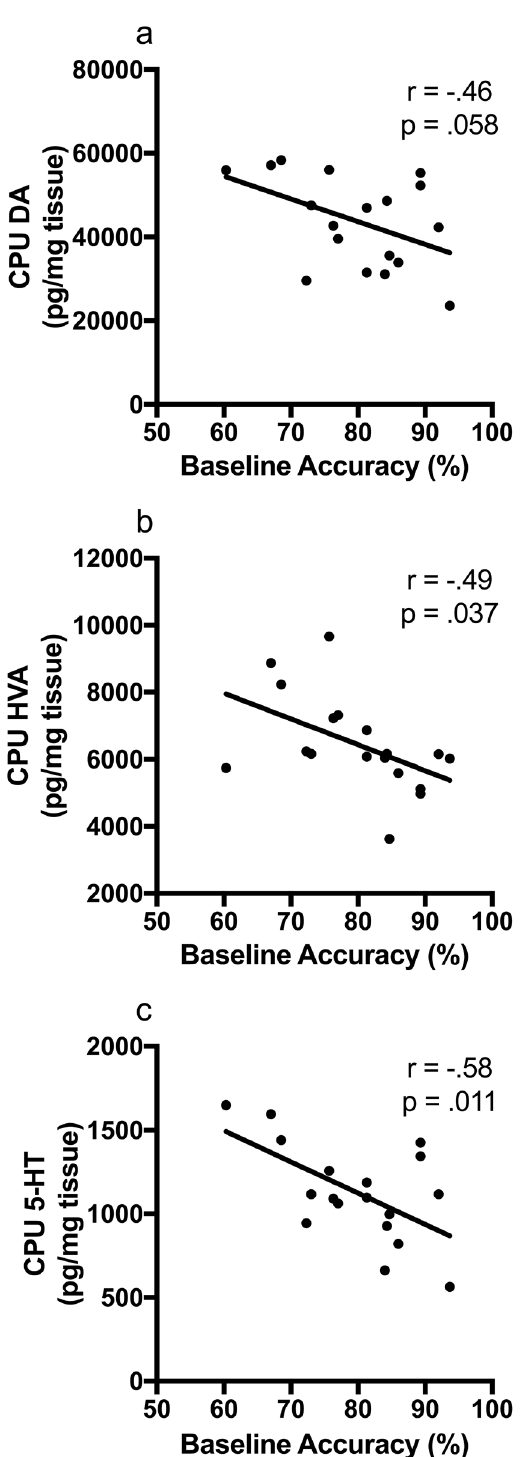
Figure 5. Striatal (CPU) levels of ( a ) dopamine (DA) showed a negative trend but were not significantly correlated with baseline performance accuracy ( r = − 0.46, p = 0.058). However, ( b ) homovanillic acid (HVA) ( r = − 0.49, p = 0.037) and ( c ) serotonin (5-HT) levels ( r = − 0.58, p = 0.011) were significantly negatively correlated with baseline performance ( N =